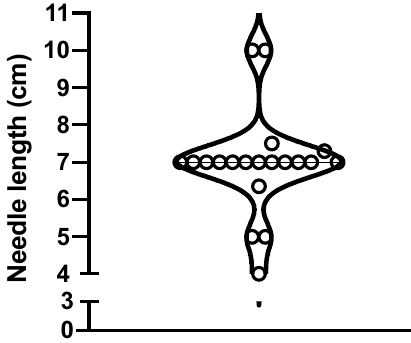
Figure 2. Violin plot of the needle length of Seldinger needles in the market research (n =